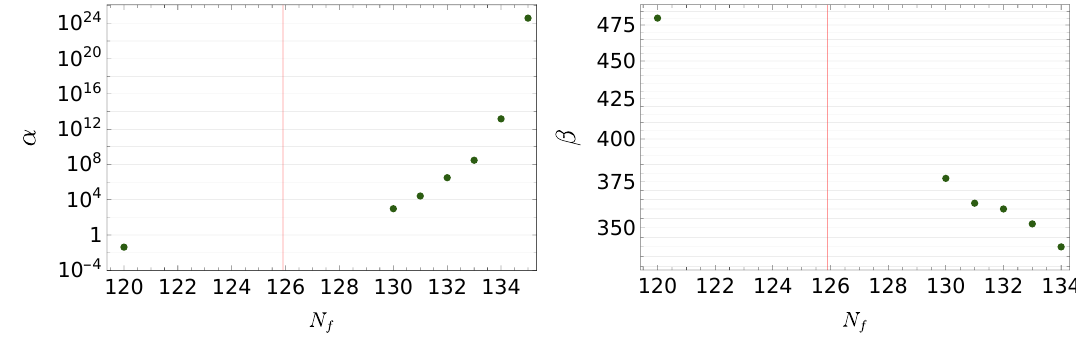
Figure 4 . We represent, on the left the values of the normalized energy budget (cid:11) ( T p ) and, on the right, the velocity of the transition (cid:12) at the time of percolation as a function of the number of